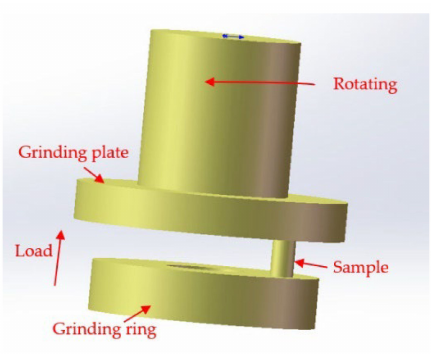
Figure 4. A schematic diagram of the work scheme for the abrasion